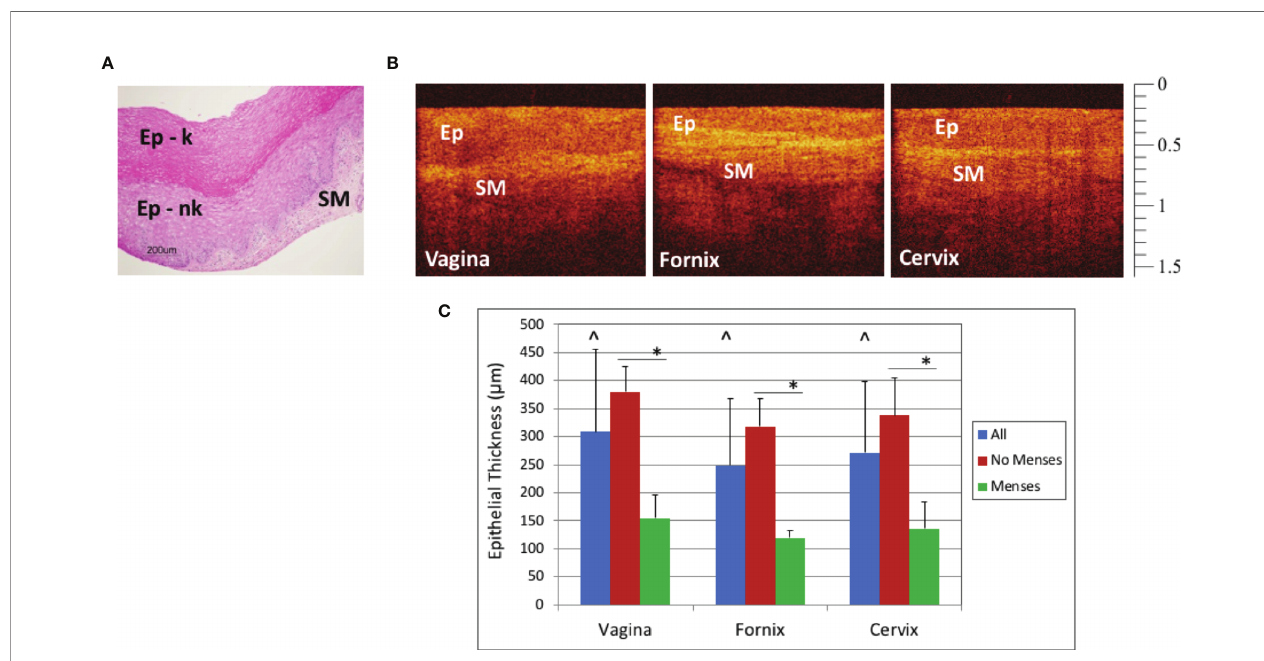
FIGURE 2 | Baseline Optical Coherence Tomography (OCT) and Histology Findings - Representative baseline histology image (hematoxylin and eosin, H&E) of vaginal epithelium with keratinizing (Ep-k) and nonkeratinizing (Ep-nk) epithelium overlying the lamina propria of the submucosa ( A , scale bar 200 m m) and OCT images from the macaque vagina, fornix, and cervix in which the epithelium (Ep), and the submucosa (SM) can be visualized B , OCT calibration bar is in mm, with small tick mark = 100 m m). Baseline epithelial thickness in the vagina, fornix, and cervix was measured by OCT imaging. The vagina was signi fi cantly thicker than the fornix (p<0.001) and cervix (p=0.001) and the cervix was signi fi cantly thicker than the fornix (p=0.03, signi fi cance indicated by ^). Baseline epithelial thickness in the vagina, fornix, and cervix in mensing macaques was thinner when compared to that of non-mensing macaques. ( C , p < 0.001, signi fi cance indicated by *). Error bars represent standard